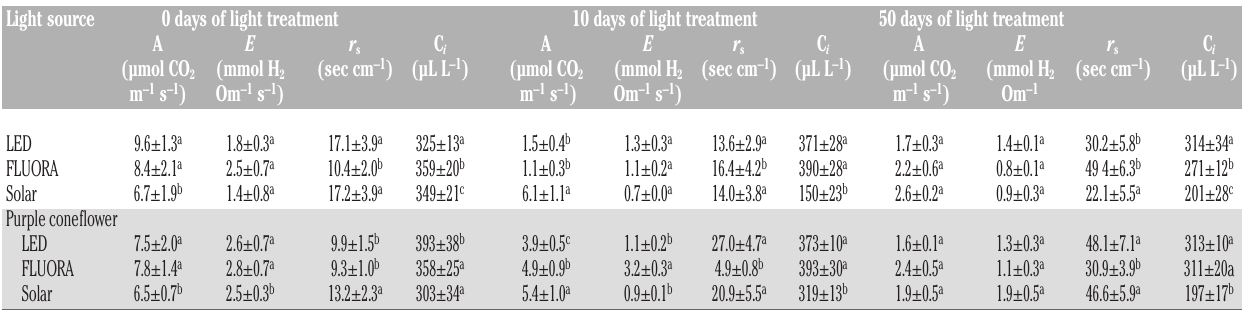
Table 2. Net photosynthesis (A), transpiration (E), stomatal resistance (rs), and intercellular CO2 (Ci) in leaves of common dandelion and purple coneflower seedlings grown under light-emitting diodes (LED), FLUORA and solar light sources. Light source